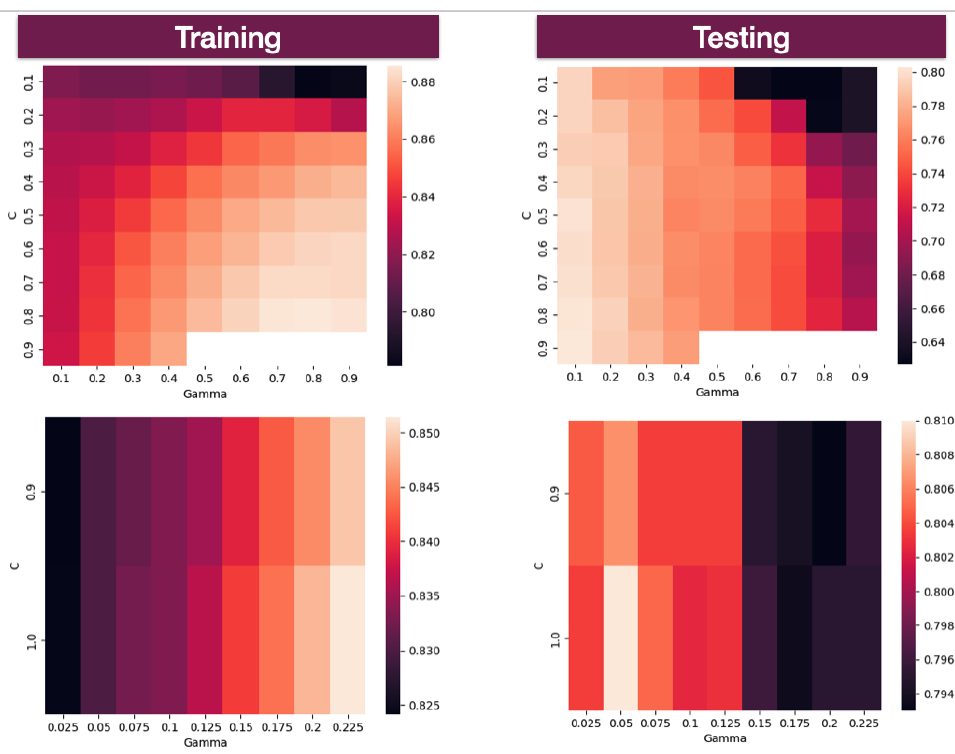
Figure 13. Grid search heatmap. Table 4. Kernels in cascaded SVC and BMI super